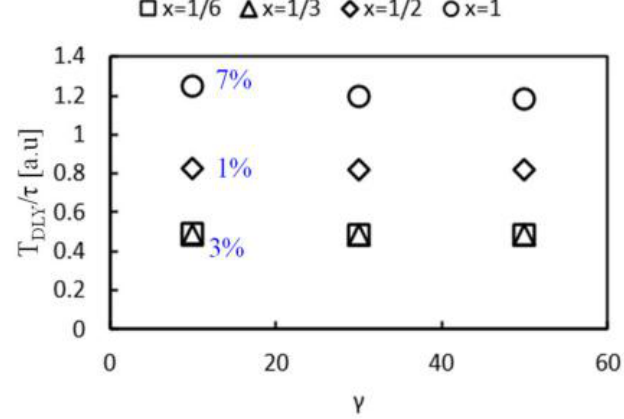
Figure 13. T DLY vs. γ with x-dependent optimum T PRE